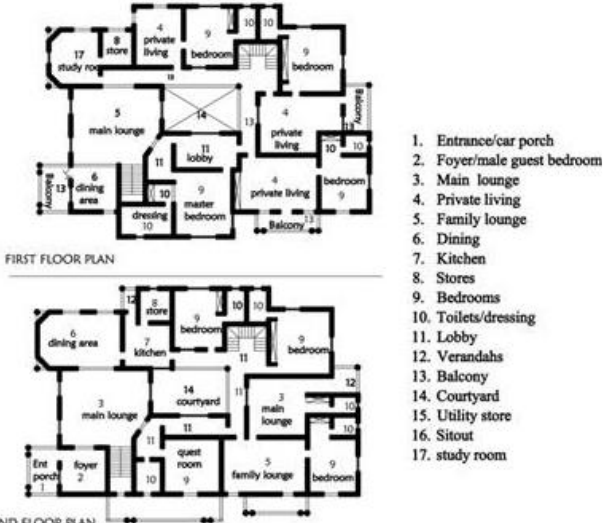
Figure 9. Plan of a Contemporary Hausa Building Designed by Zailani and Sa’ad Raji (Aliyu, 2015).